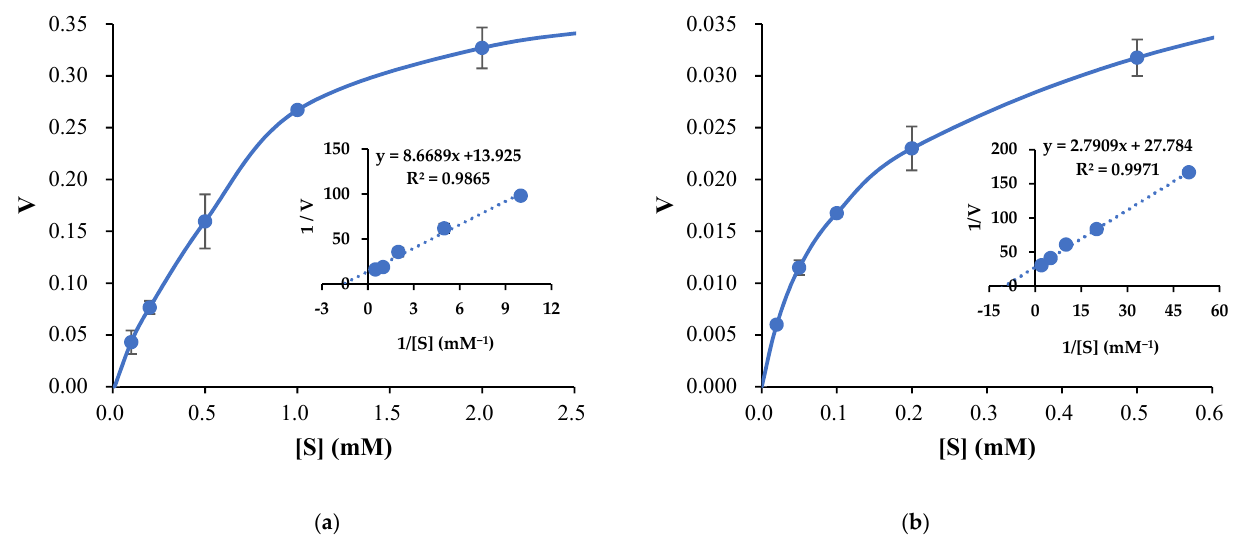
Figure 8. Michaelis–Menten and Lineweaver–Burk plots of Est2L ( a ) and Est4L ( b ) for C4. Experiments were performed at five different substrate concentrations of 0.1, 0.2, 0.5, 1.0, and 2.0 mM of C4.